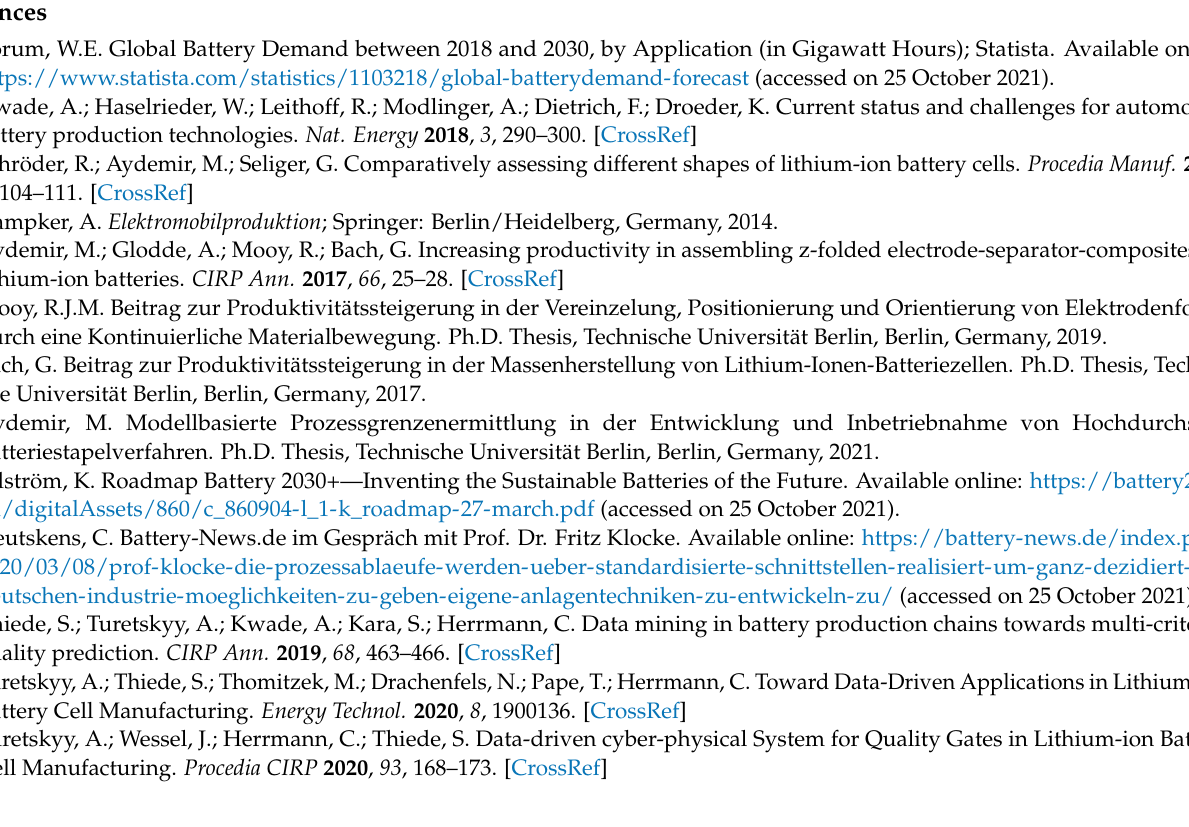
Figure A1. Normal stresses in x- and y-directions at the end of the folding motion for the ceramic separator and different web tension